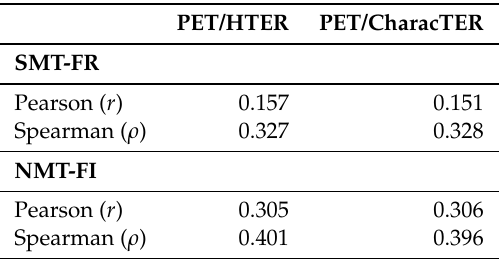
Table 3. Correlation between temporal post-editing effort (post-editing time, PET) and technical effort measures (HTER and CharacTER) per language department.